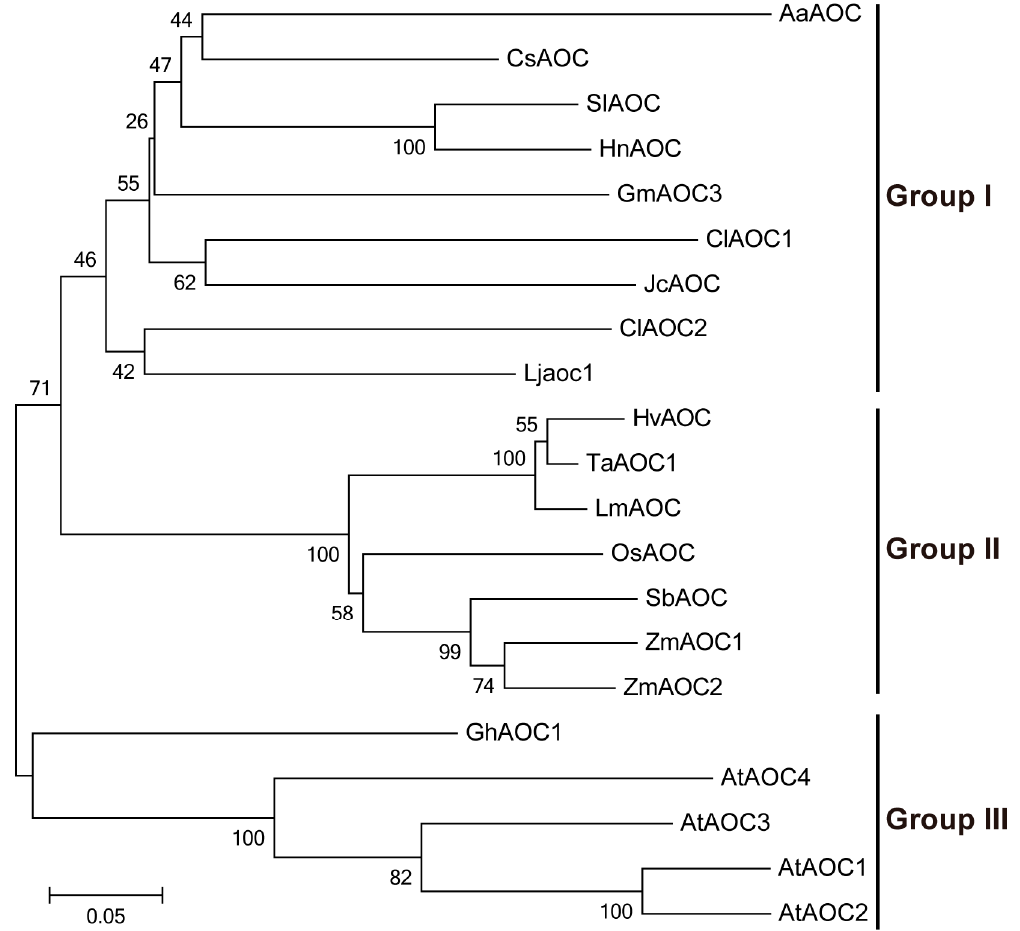
Figure 3. Phylogenetic analysis of AOC proteins from different plant species. The phylogenetic tree was created by MEGA 7.0 using the NJ method based on full-length amino acid sequences of AOC proteins from different plant species. The bootstrap value was set to 1000 replicates. The protein IDs and sources of all AOC proteins are listed in Table S2.